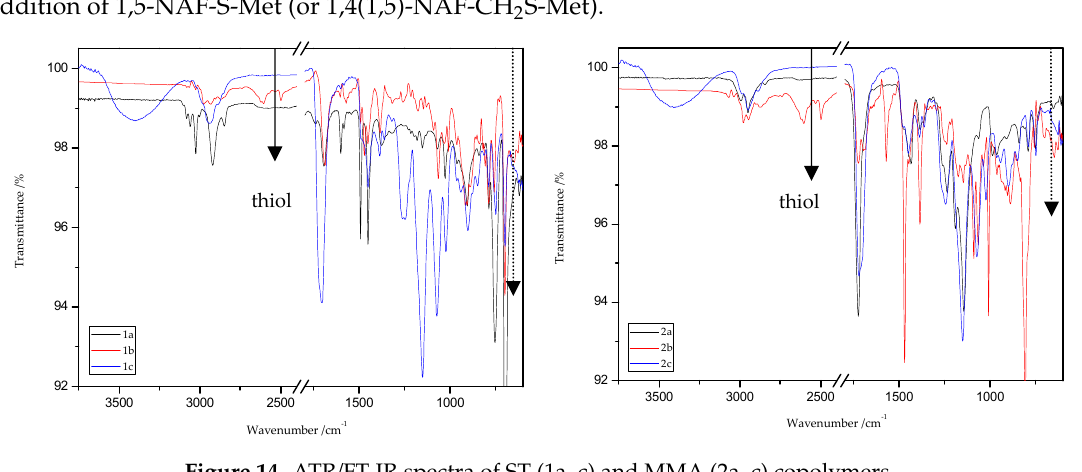
Figure 14. ATR/FT-IR spectra of ST (1a–c) and MMA (2a–c) copolymers.